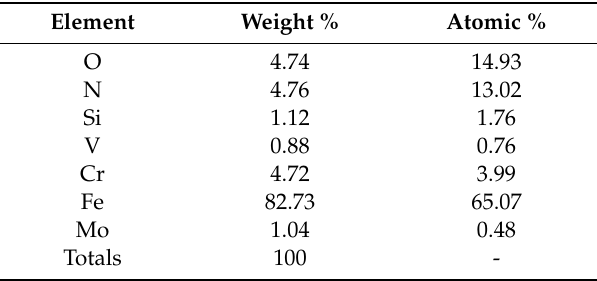
Table 4. EDS analysis of area B in Figure